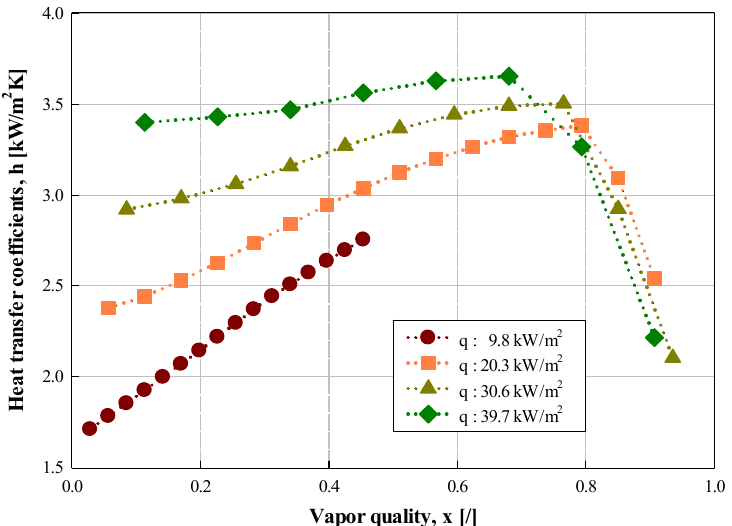
Figure 9. Variation in heat transfer coefficients according to various saturation temperatures at constant mass and heat fluxes (G: 200 kg/(m 2 ·s) and q: 20 kW/m 2 ).